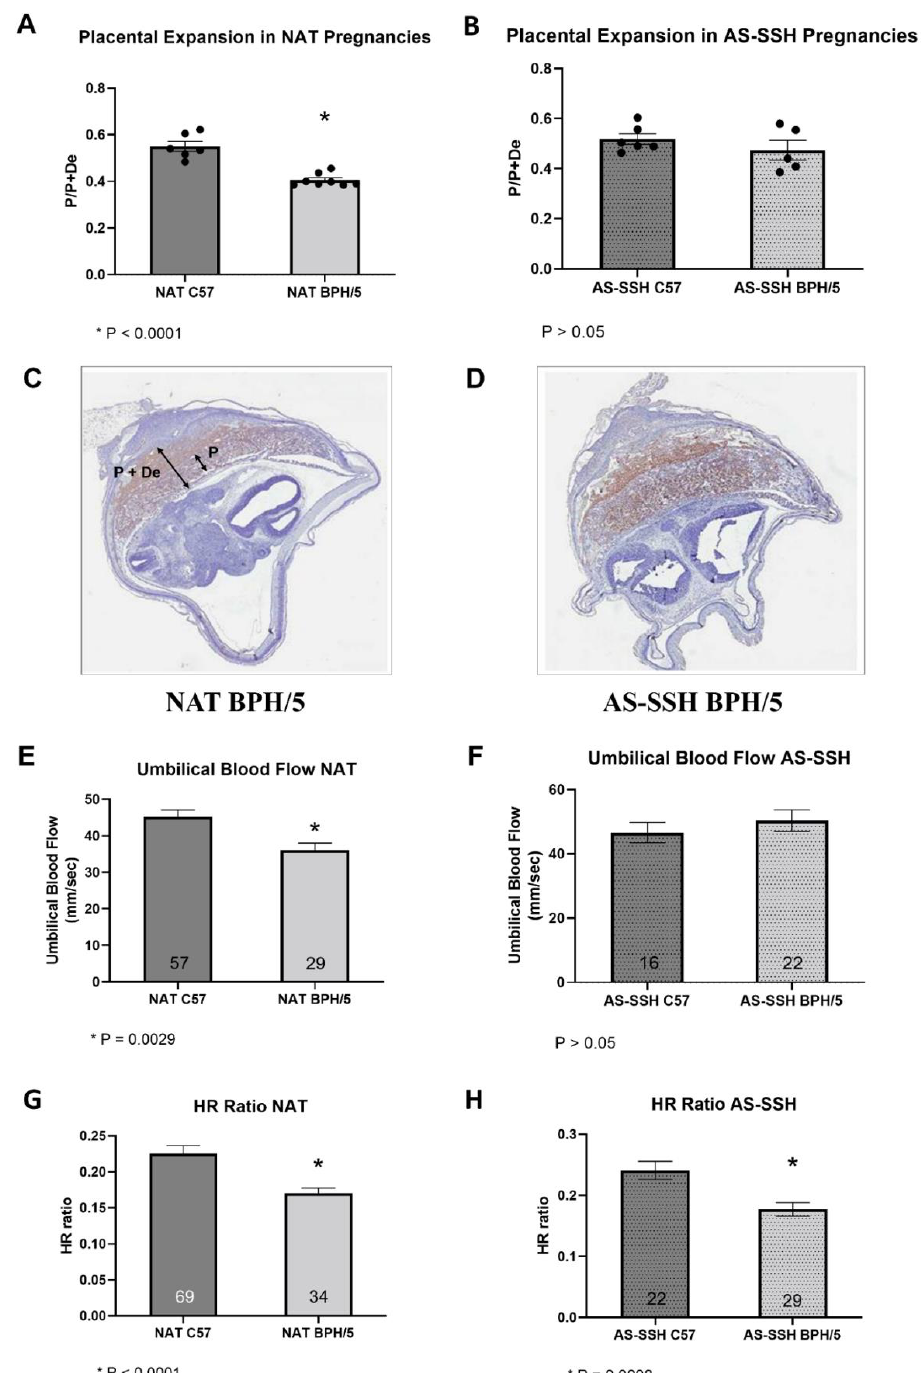
Figure 6. Placentation and umbilical cord blood flow are improved in BPH/5 females after artificial synchronization of sex steroid hormones (AS-SSH). ( A , B ) Rate of placental expansion in the maternal decidua, calculated as the ratio of placental depth (P) in relation to the placenta + maternal decidua (P + De, n = 5–8/group). Student’s t -test, * p < 0.0001 vs. NAT C57. ( C , D ) Representative photomicrographs of Isolectin B4-stained fetoplacental units of ( C ) natural (NAT) and ( D ) AS-SSH BPH/5 females, 100 × magnification. ( E – H ) Ultrasonographic measurements of umbilical blood flow and heart rate (HR) ratio, expressed as a ratio of fetal to maternal heart rate in fetoplacental units of BPH/5 and C7 females carrying NAT and AS-SSH pregnancies ( n = 16–69/group). Student’s t -test, * p < 0.05. Data expressed as mean ±